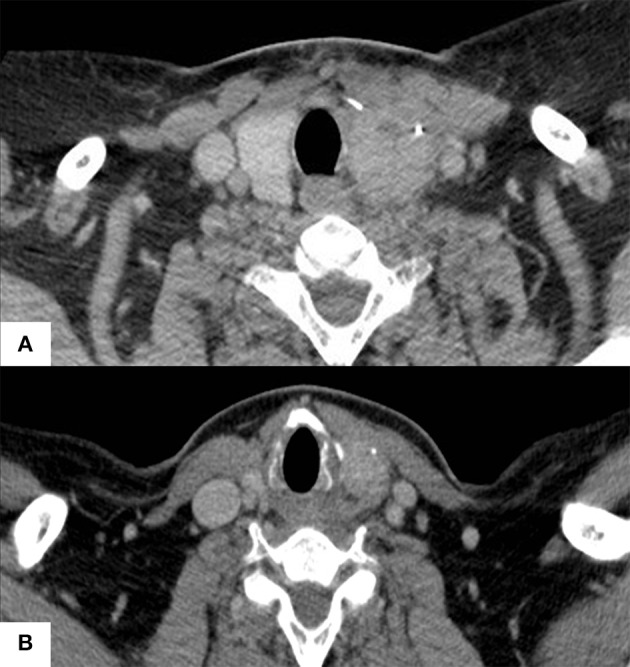
Thyroid CT scans pre (A) and after 6 months (B) of neoadjuvant sorafenib therapy.